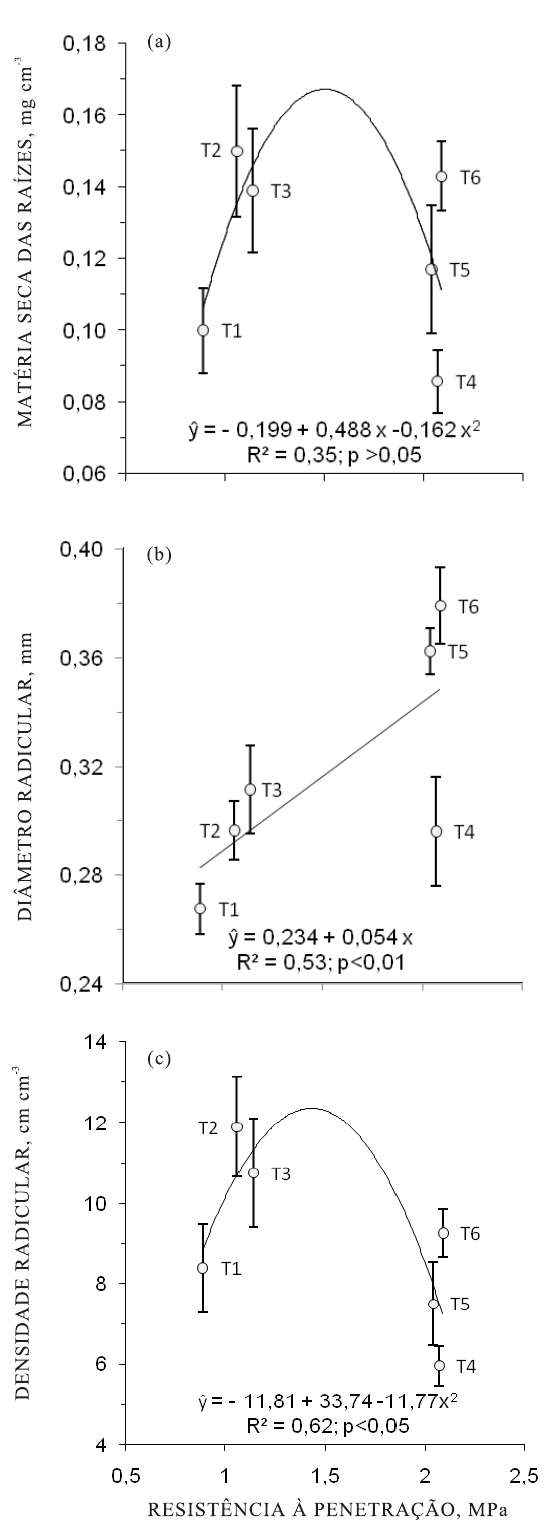
Figura 7. Regressão entre a resistência à penetração do Latossolo Vermelho na profundidade de 10– 20 cm e a massa de matéria seca das raízes, diâmetro radicular e densidade do comprimento radicular. As barras referem-se aos erros-padrão